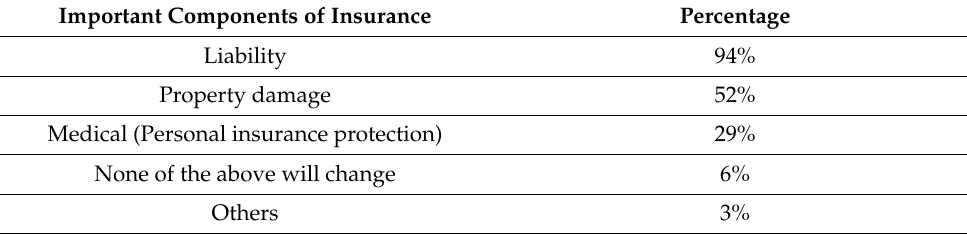
Table 1. Most important components of insurance with AVs (multiple responses allowed) adapted from [2].